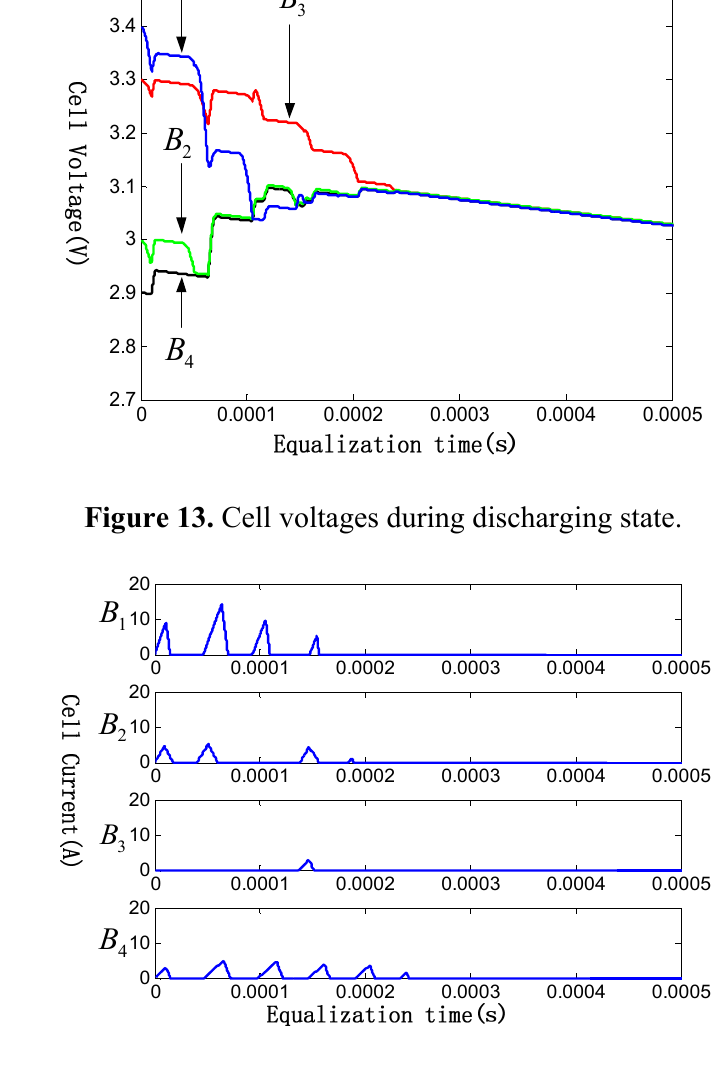
Figure 14. Balancing currents during discharging